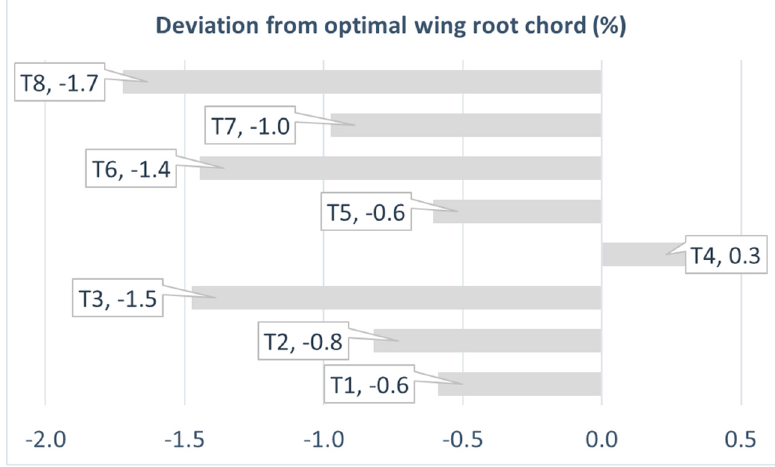
Figure 11. Technology sensitivity analysis: deviation from optimal wing root chord target value.